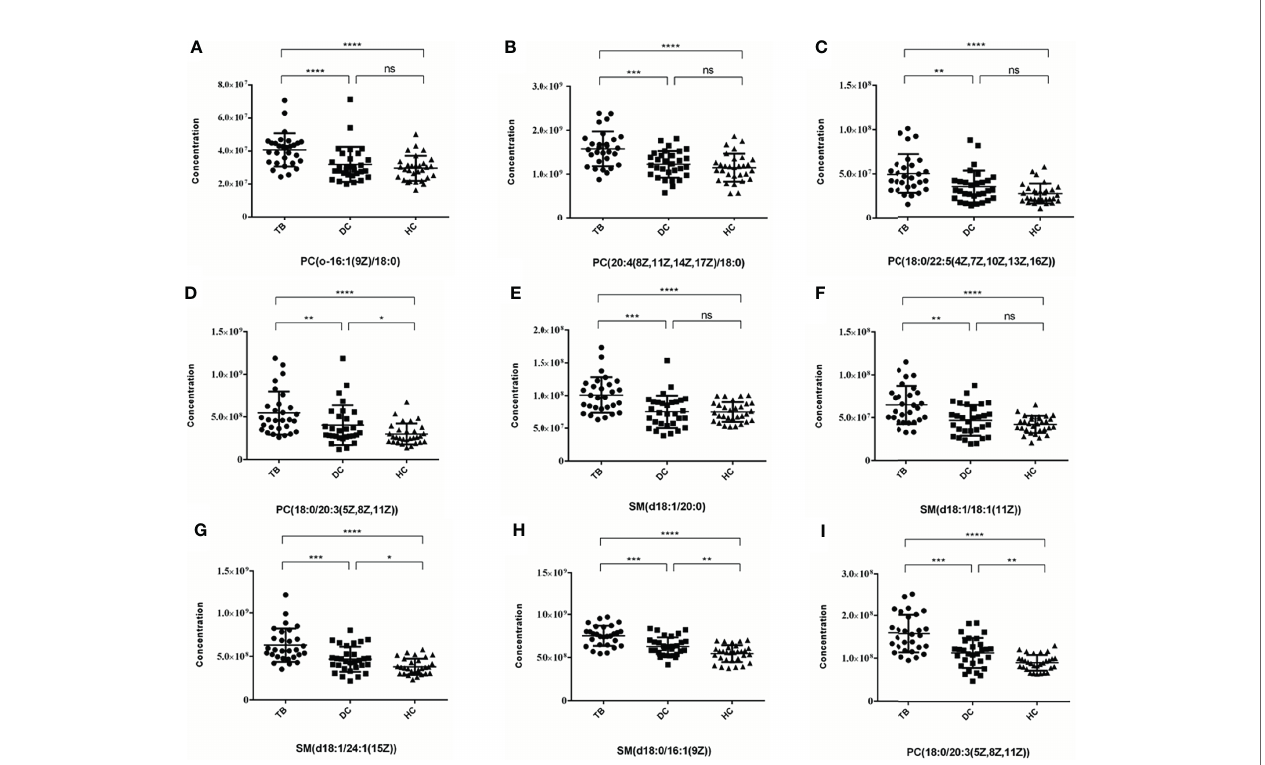
FIGURE 5 | Scatter plots of 9 selected differential metabolites among TB, DC and HC Group. (A) PC(o-16:1(9Z)/18:0); (B) PC(20:4(8Z,11Z,14Z,17Z)/18:0); (C) PC (18:0/22:5(4Z,7Z,10Z,13Z,16Z)); (D) PC(18:0/20:3(5Z,8Z,11Z)) (E) SM(d18:1/20:0); (F) SM(d18:1/18:1(11Z)); (G) SM(d18:1/24:1(15Z)); (H) SM(d18:0/16:1(9Z)); (I) PC